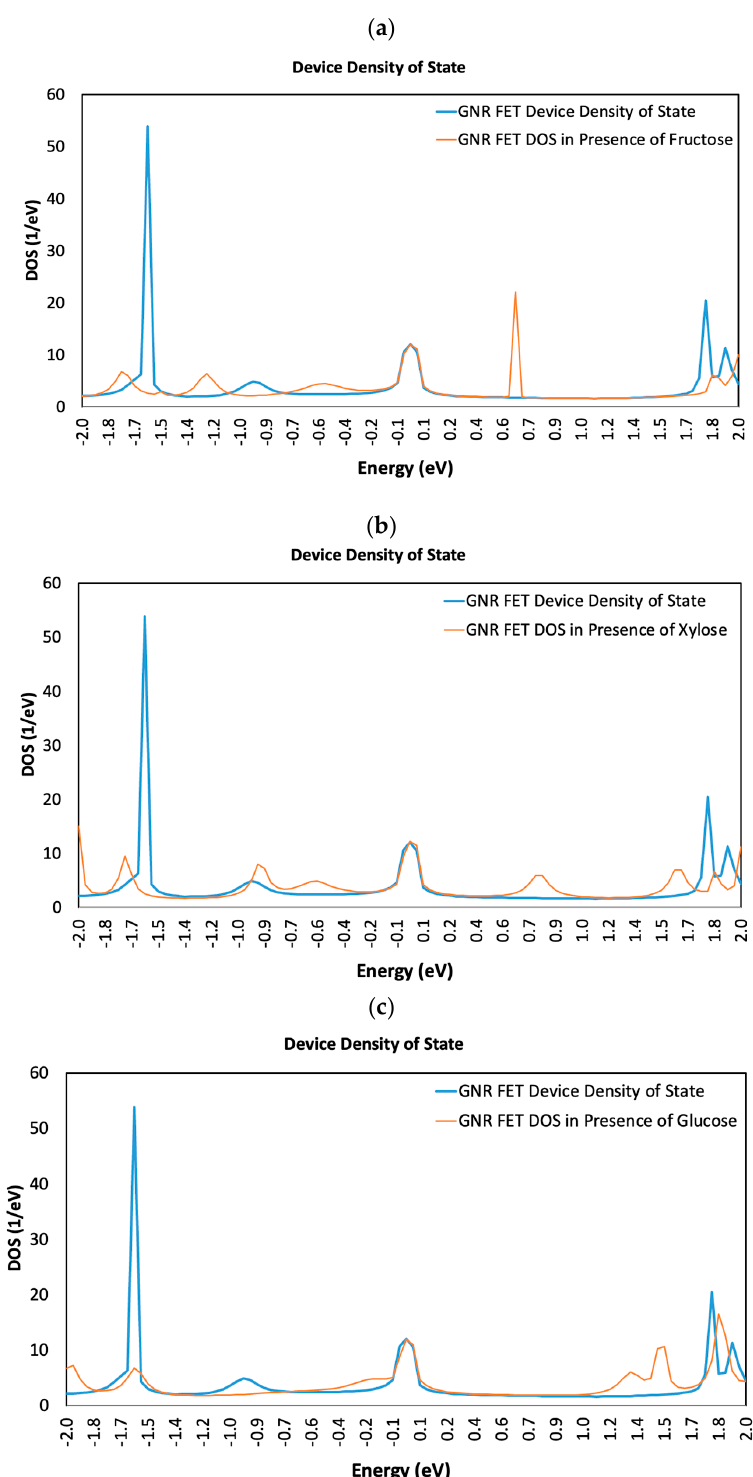
Figure 5. Variation in device density of states (DDOS) of simulated GNR-FET in presence of ( a ) Fructose molecule; ( b ) Xylose molecule; and ( c ) Glucose molecule.